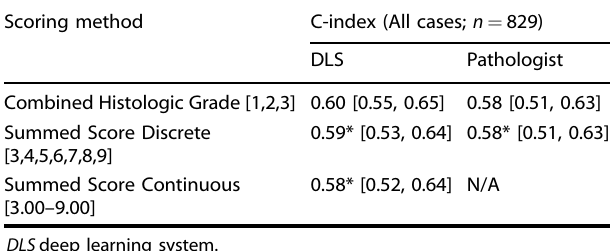
Fig. 1 for details regarding dataset usage and characteristics.